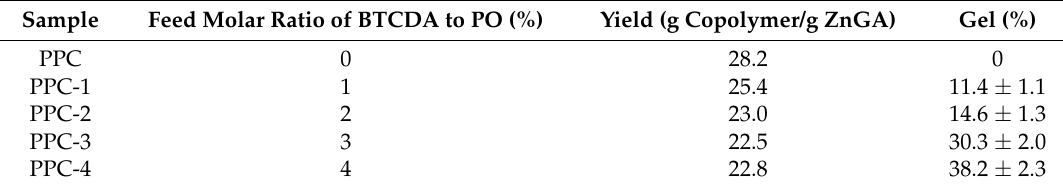
Table 1. The results of yields and gel contents of PPC and PPC with networks.